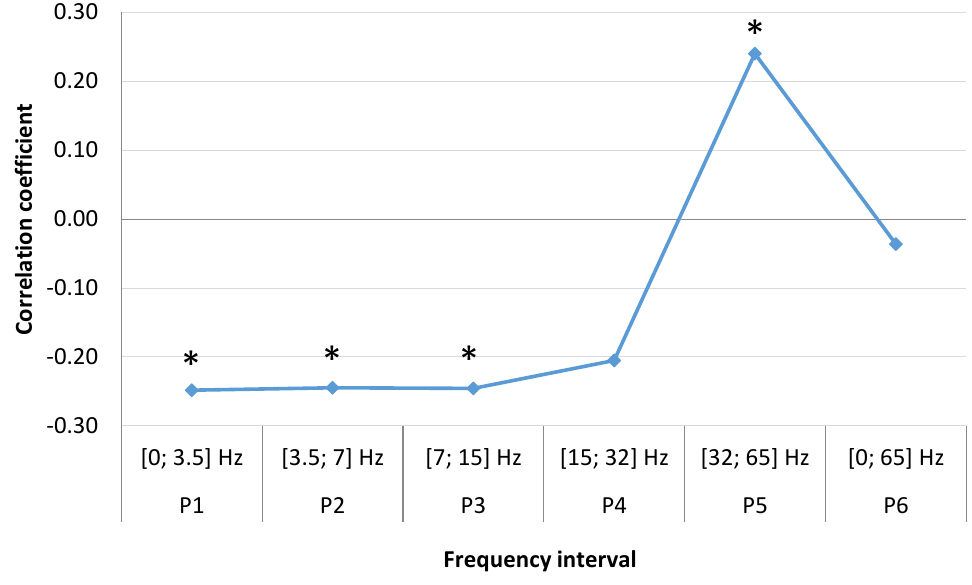
Figure 5. Correlation between number of weekly MI cases in women and mean magnetic power in different frequency ranges spanning a time of one week (data from LUHS, Cardiology clinic, 2016), * p < 0.05.